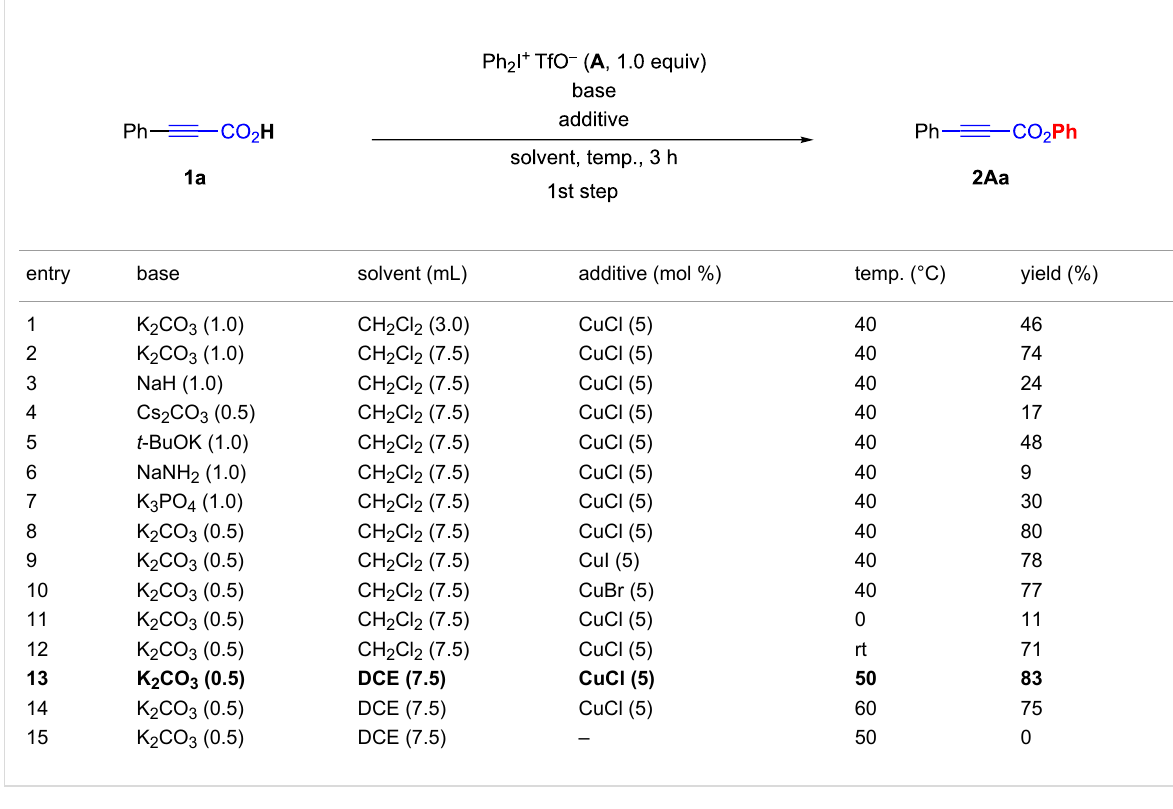
Table 1: O-Phenylation of 3-phenyl-2-propynoic acid ( 1a ) with diphenyliodonium triflate ( A ).